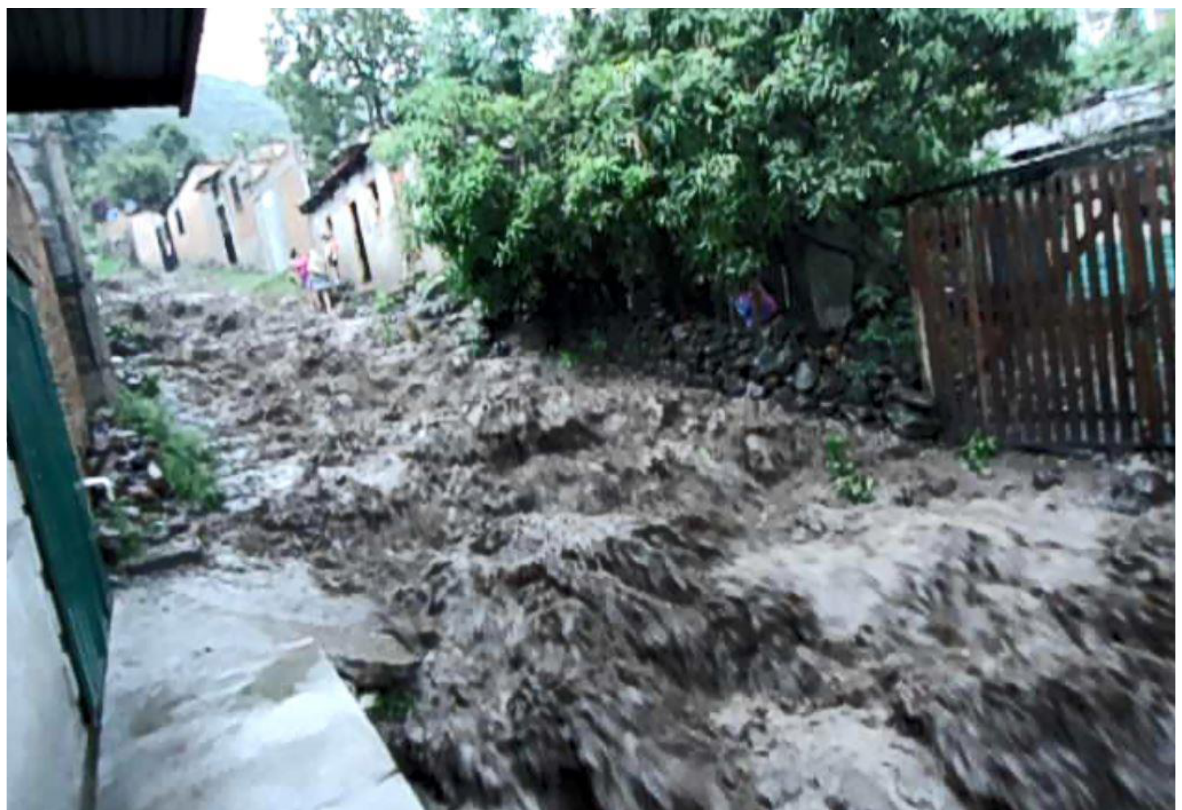
Figure 3. A street transformed into a stream channel during a heavy storm within the study area (courtesy of the Tegucigalpa Municipality, Alcaldía del Municipio del Distrito Central).